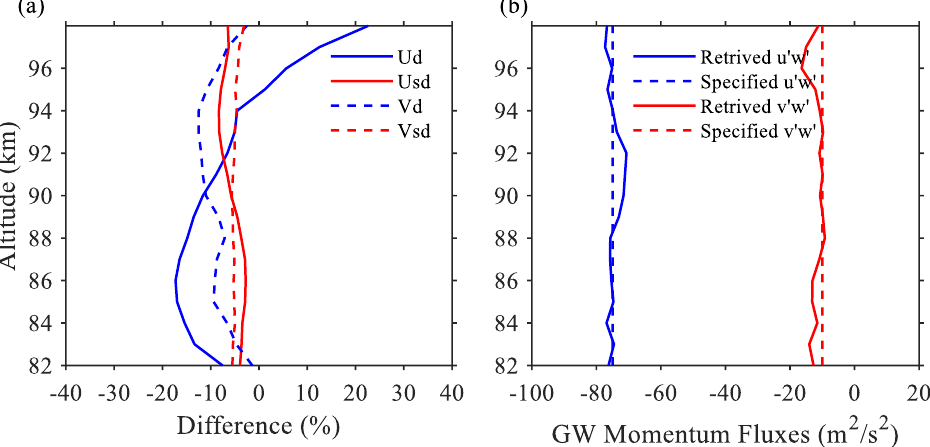
Figure 5. ( a ) Differences of the amplitudes of the diurnal (red lines) and semidiurnal (blue lines)